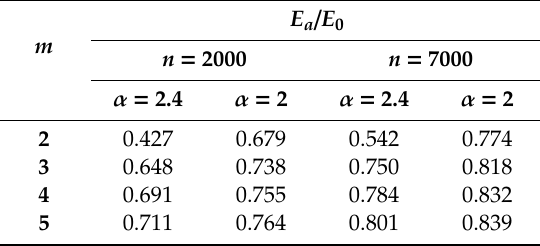
Table 1. The relative cohesive energy of nanoparticles in a face-centered cubic structure includes n = 2000 and 7000 atoms for di ff erent values of m and α .